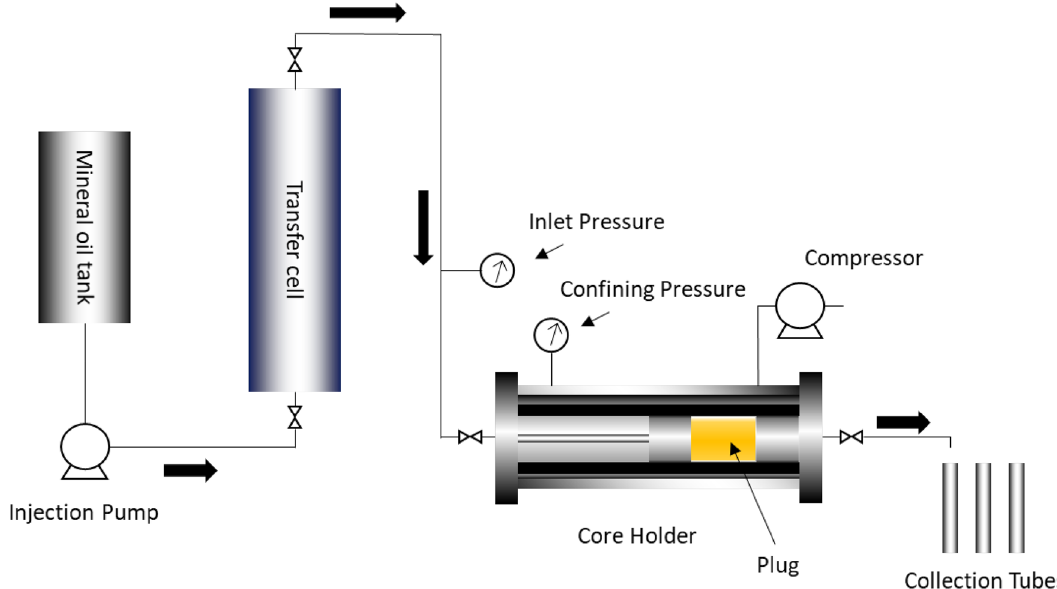
Fig. 1 Experimental reservoir simulator